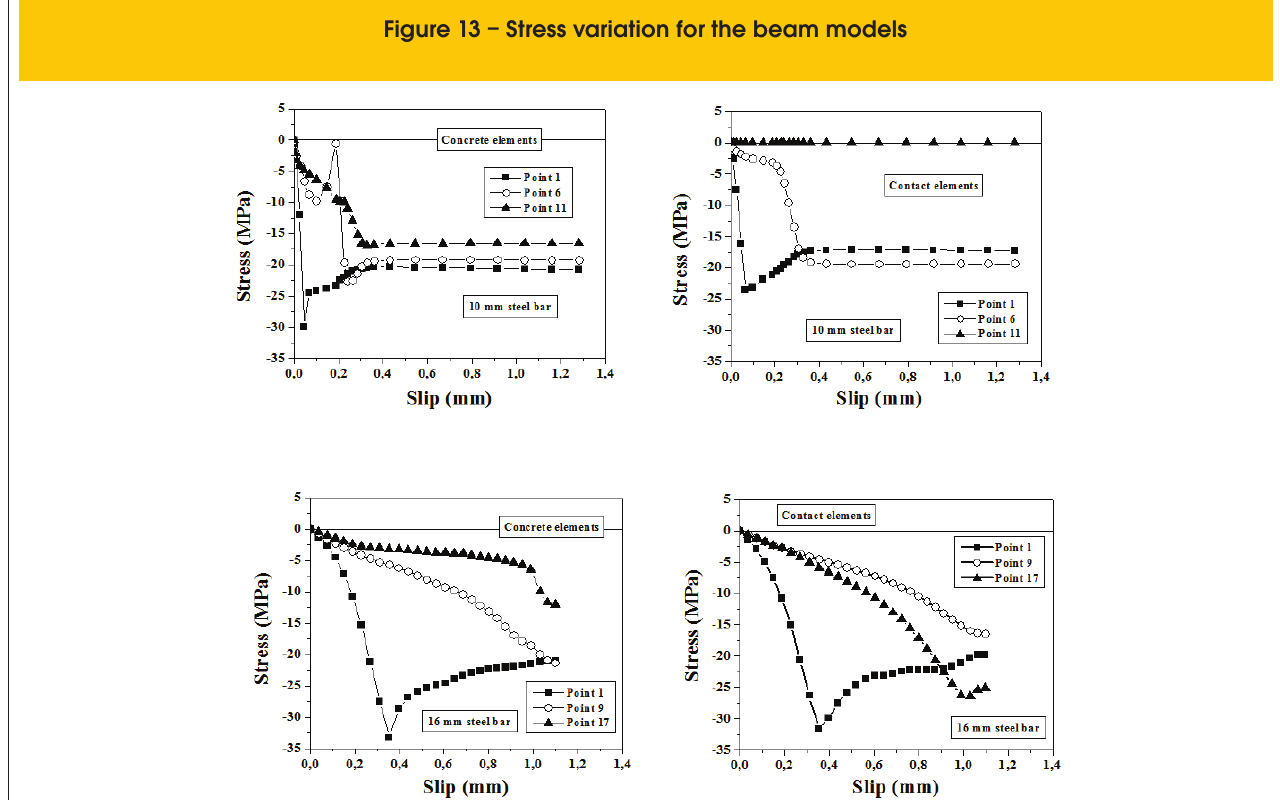
Figure 13 – Stress variation for the beam